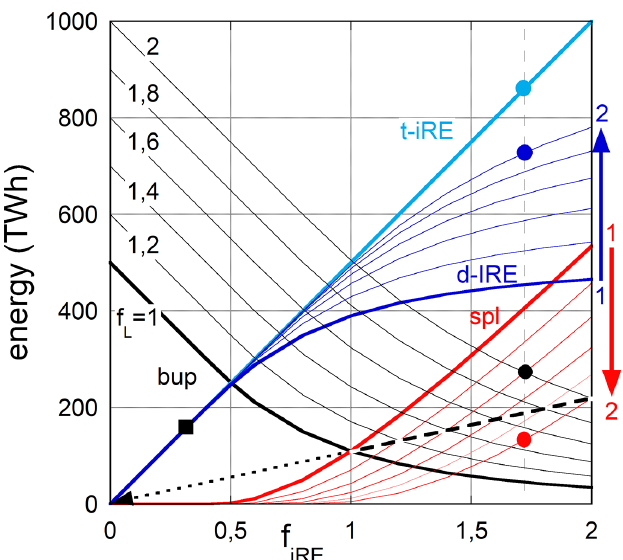
Fig. 7. – This diagram is an extension of fig. 6(a) when additionally, the consumption is varied. The consumption is parametrised by f L = annual consumption/target load. The fat curves are reproduced from fig. 6 with f L = 1. The thin lines represent the variation of bup, t-iRE, d-iRE and spl when f L is varied from 1 to 2 (see arrows), whereas each set starts with the fat curves of f L = 1. The dashed linear line denotes the special cases where spl = bup. They are dubbed 100% cases because spl would conceptually allow replacing bup by storage if storage losses were ignored. The square denotes the German situation in 2018; the dots the situation of Germany in 2045 expected from the AGORA installed iRES capacity [10] and processed on the basis of 2019